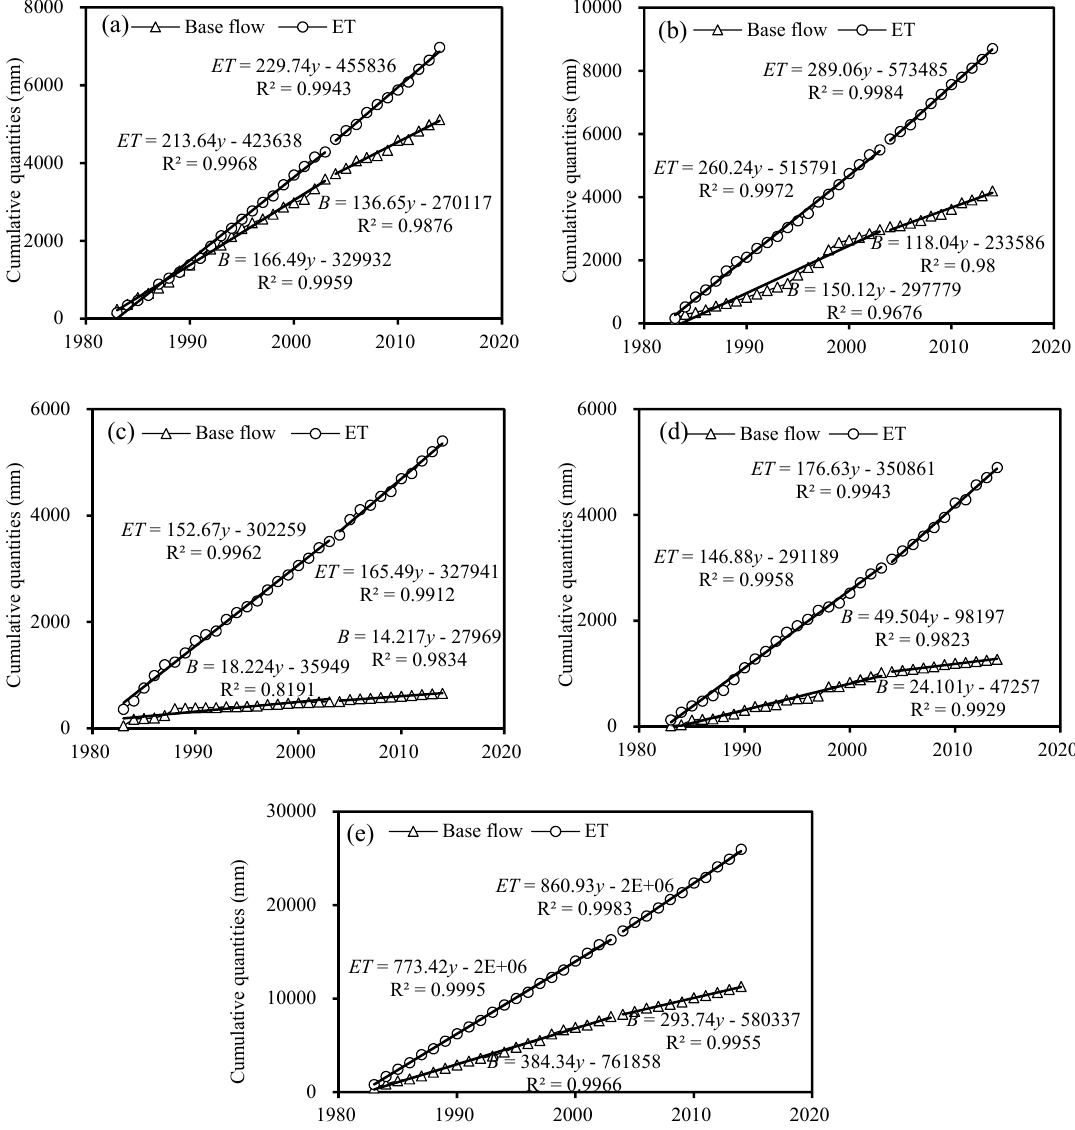
Figure 8. Relationships between year and cumulative base flow, ET in spring ( a ), summer ( b ), autumn ( c ), winter ( d ) and whole year ( e ) during two periods in Pengchongjian small watershed.